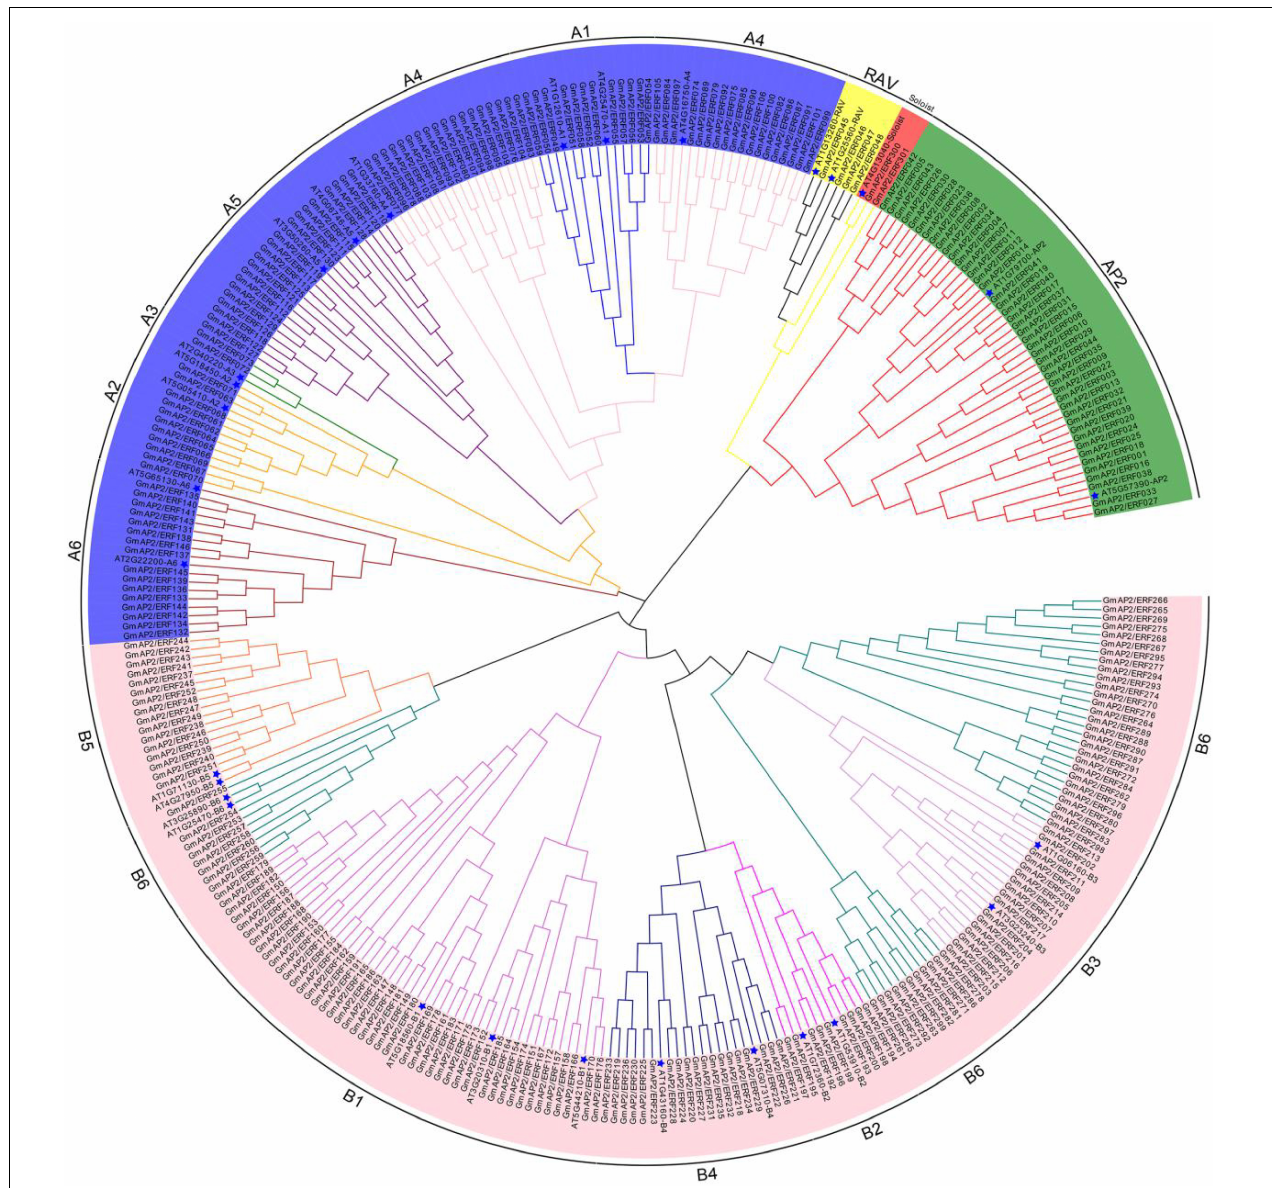
FIGURE 1 | Phylogenetic tree of GmAP2/ERF proteins in soybean and Arabidopsis. Five subfamilies are highlighted by different colors. Arabidopsis is marked with a blue